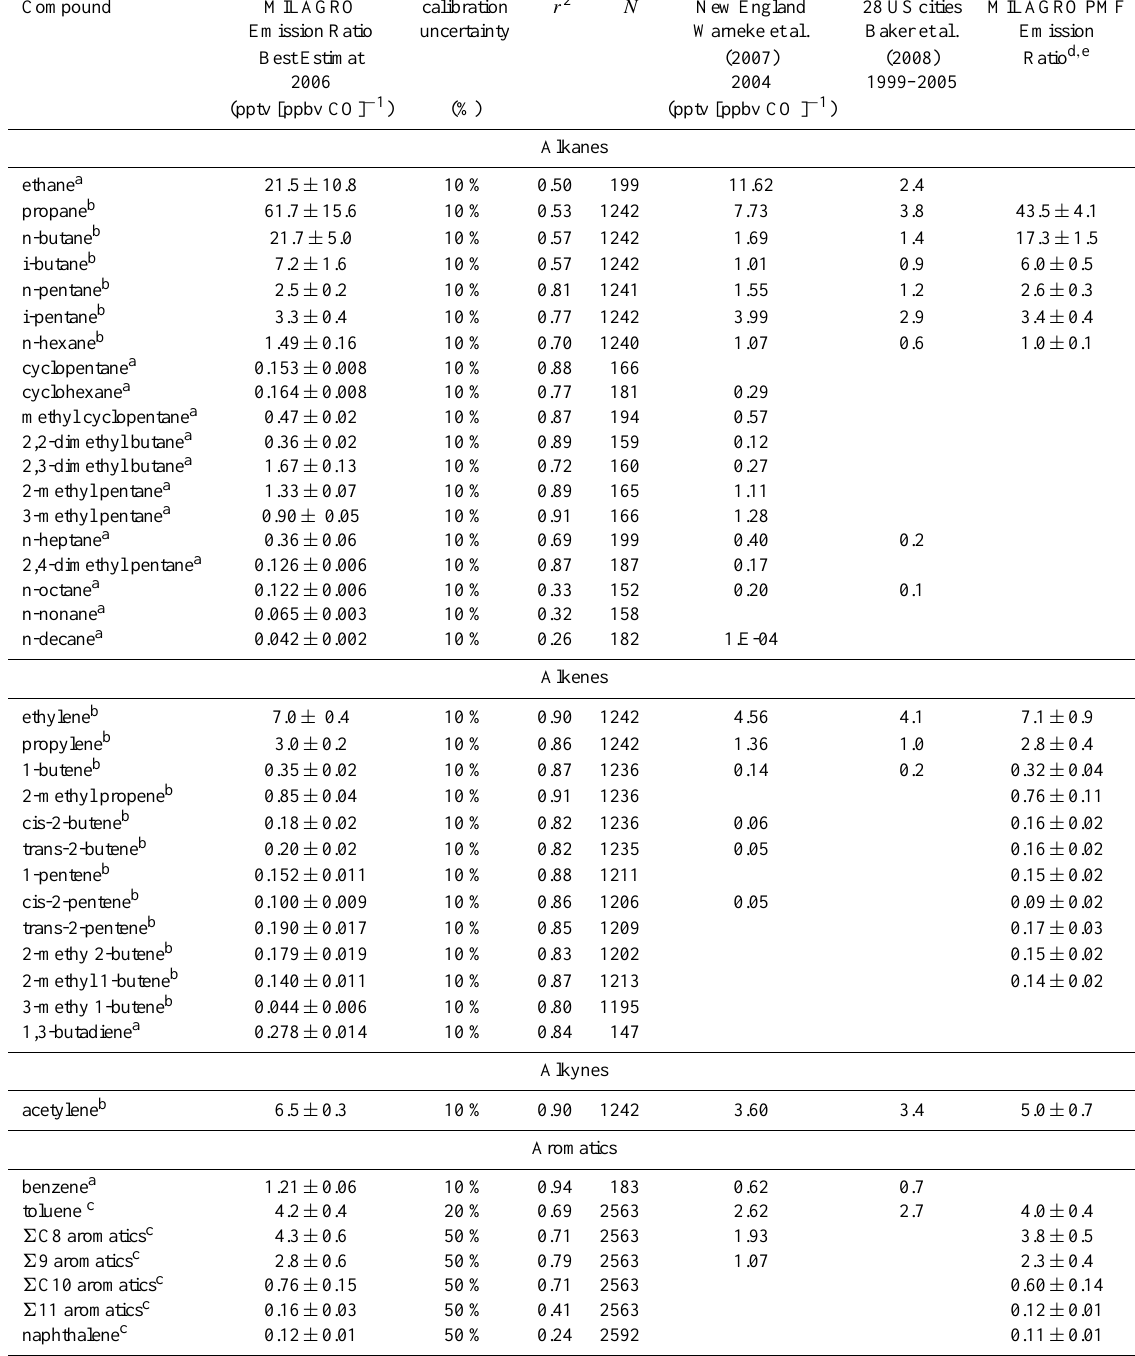
Table 3. Urban emission ratios for non-methane hydrocarbons quantified during MILAGRO versus carbon monoxide are compared to PMF- derived emission ratios and values for US cities from the literature. Correlation coefficients ( r 2 ) and the number of points fit (N) are shown for measurement derived emission ratios. Reported errors for measurement-derived emission ratios are 1 σ uncertainties in the slope of the ODR fit. Uncertainties reported for the PMF-derived emission ratios were calculated using the method described in the